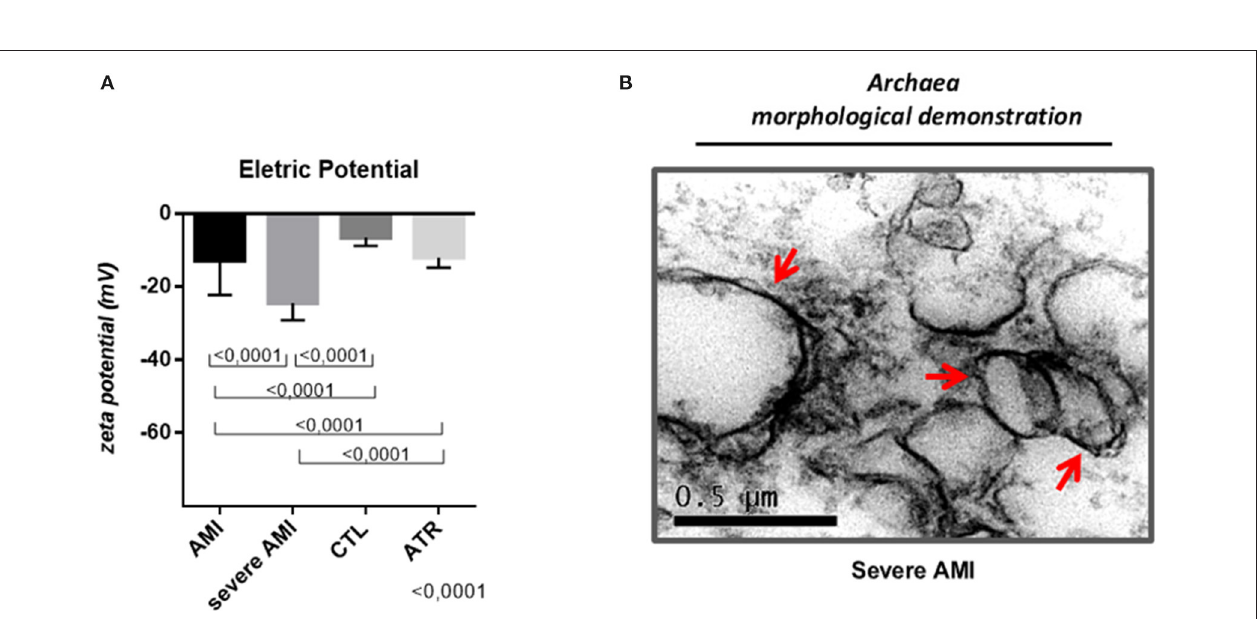
ATR [2,304 (926.4–4,074)] groups (Kruskal-Wallis, p < 0.0001; Figure 7C ). The IF γ level of the CTL group [263.6 (0.0–11,645)] was increased compared to that of the severe AMI group